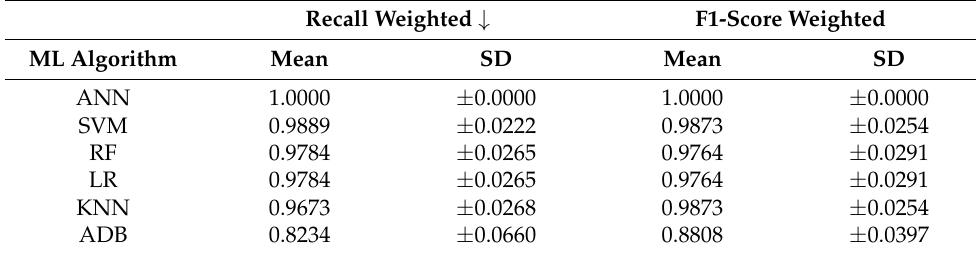
Table 4. Main classification metrics with